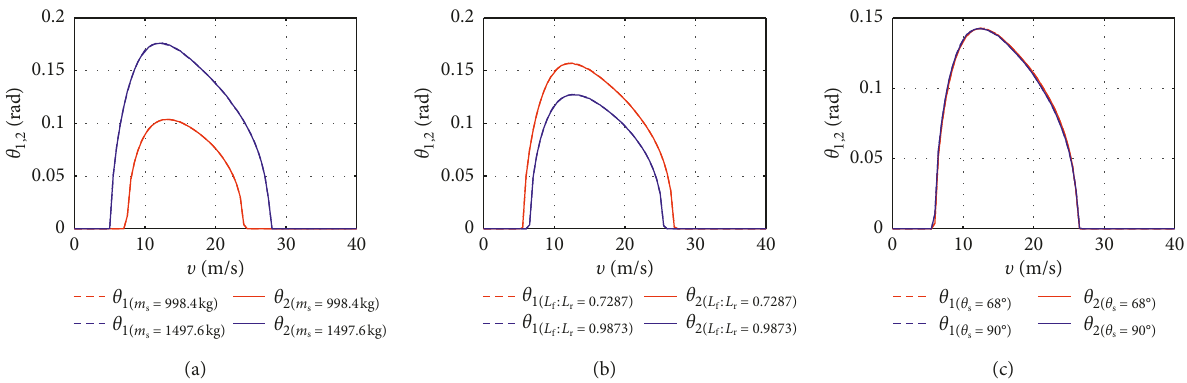
Figure 11: Influences of vehicle parameters on the critical velocity of vehicle shimmy. (a) Influences of m Influences of θ s .